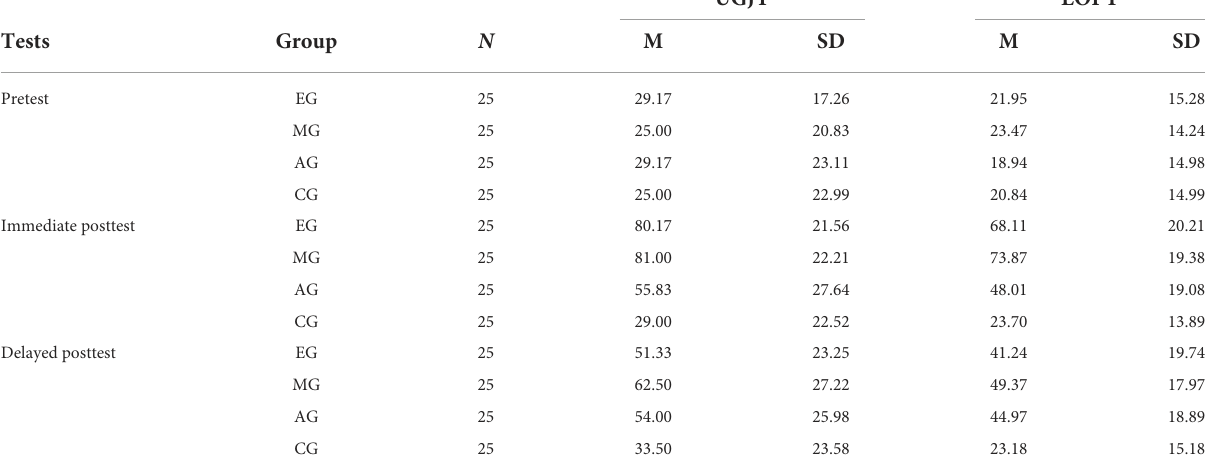
TABLE 4 Means and SDs of UGJT and EOPT scores of the four